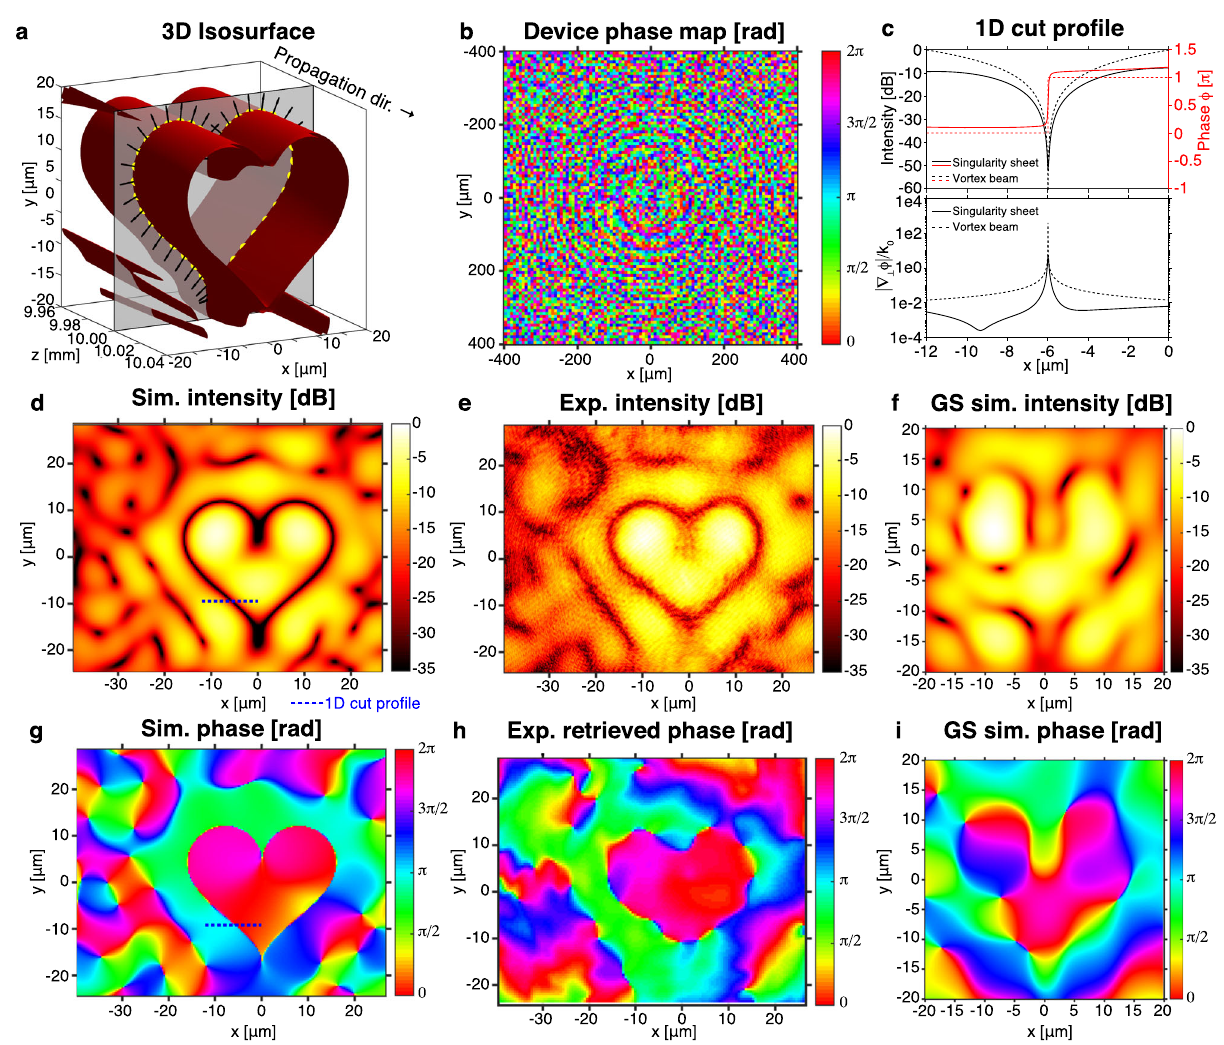
Fig. 3 An engineered heart-shaped optical phase-singularity sheet ( λ 0 = 532 nm). a Isosurface of low fi eld intensity for the simulated singularity sheet. The phase gradient was maximized in the directions indicated by the arrows on the gray z = 10 mm plane, at the locations of the yellow dots. b Inverse- designed phase pro fi le, located at z = 0 mm, which realizes the heart-shaped optical singularity. c The 1D cut pro fi le of intensity, phase, and phase gradient magnitude | ∇ ⊥ ϕ | = [( ∂ x ϕ ) 2 + ( ∂ y ϕ ) 2 ] 1/2 for the dotted blue line in d , overlaid with the corresponding quantities for a Laguerre – Gaussian vortex beam. d Simulated relative intensity and g phase pro fi le of the singularity sheet, at z = 10 mm. e Relative intensity pro fi le obtained experimentally with a fabricated metasurface and h phase pro fi le (obtained from iterative phase retrieval), at z = 10 mm. As a comparison, the results of Gerchberg – Saxton (GS) iterative optimization to get the same heart pattern on the z = 10 mm plane are plotted in f for the intensity and in i for the phase at the target plane, which demonstrates lower pattern fi delity and contrast as compared to the phase gradient maximization